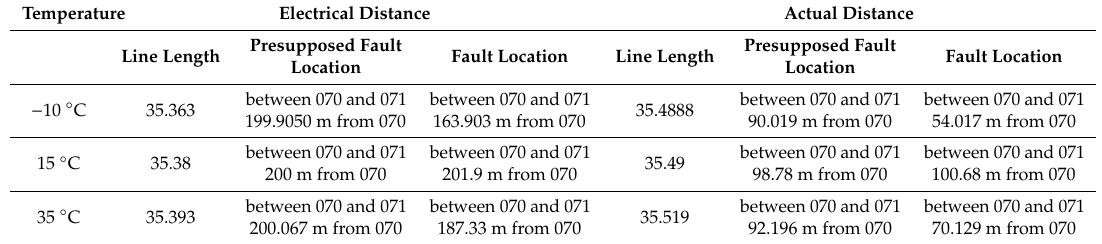
Table 2. Comparison of fault location results from the electrical and actual distance models.